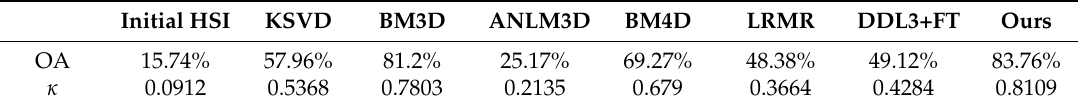
Table 1. SVM classification accuracies on heavily corrupted bands (104–108, 150–163, 220) of the Indian Pines data.